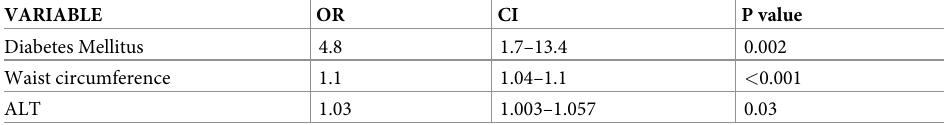
Table 8. Multivariate logistic regression analysis of variables associated with increased liver stiffness in subjects with risk factors for